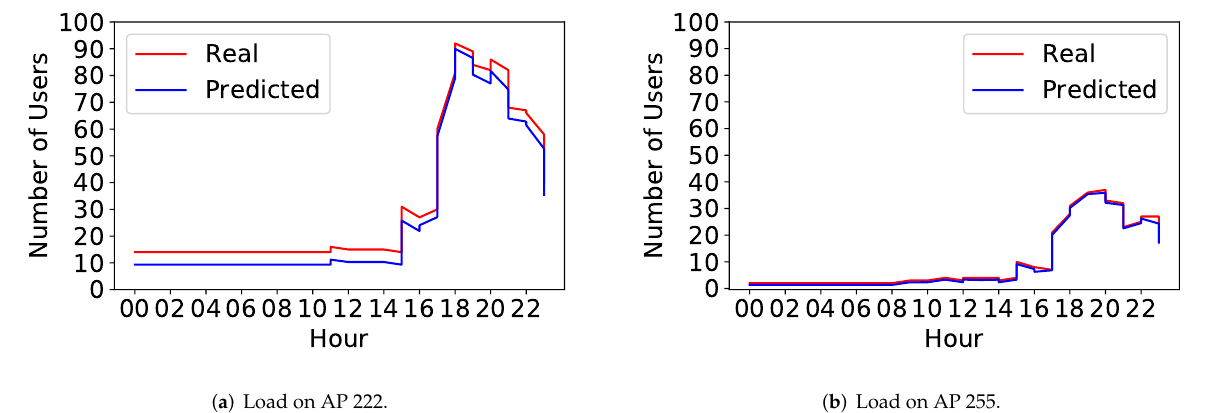
Figure 3. Comparison between actual and predicted load for Access Points 222 and 255 which are among the 20 most used APs. ( a ) AP 222 has the largest absolute cumulative error of the prediction. ( b ) AP 255 has the smallest absolute cumulative